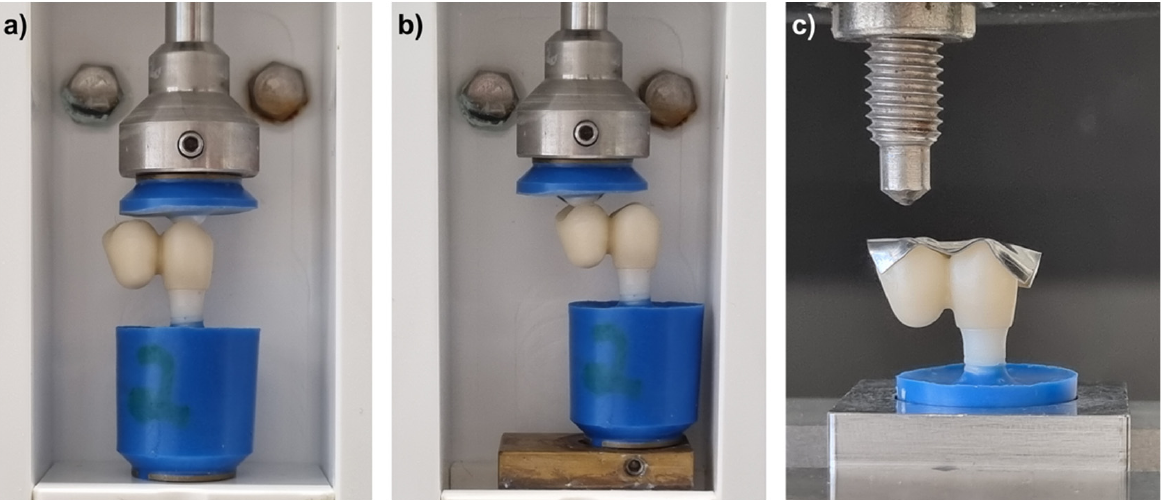
Figure 2. ( a ) Load application during chewing simulation. ( b ) Load application during chewing simulation on cantilever for additional groups ZM-E-9* and ZM-D-9*. ( c ) Load application for fracture load measurements. * = loaded on cantilever during chewing simulation.